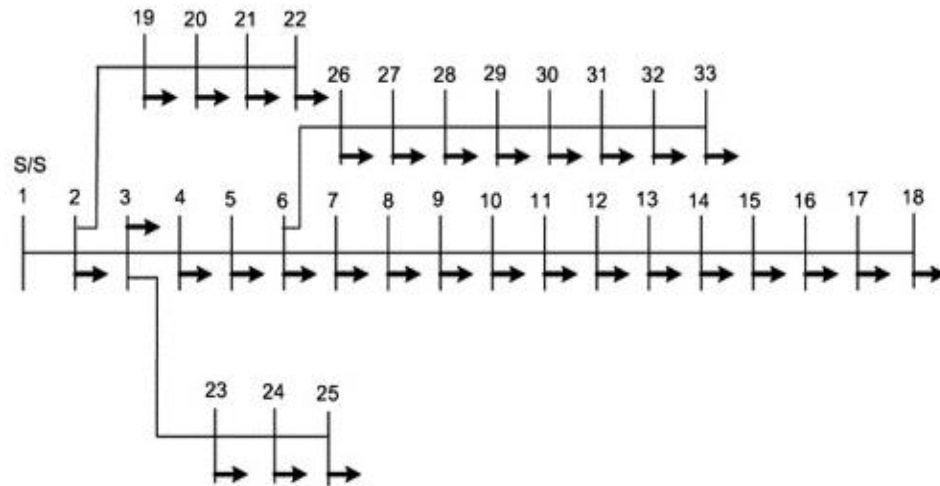
Figure 1. IEEE 33-bus distribution